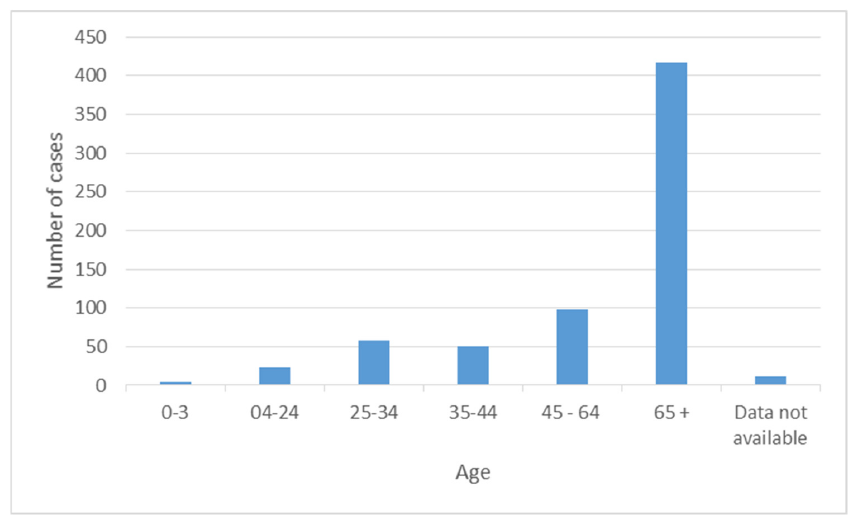
Figure 2. Number of cases versus age for the patients affected between January 2014 and March 2016.